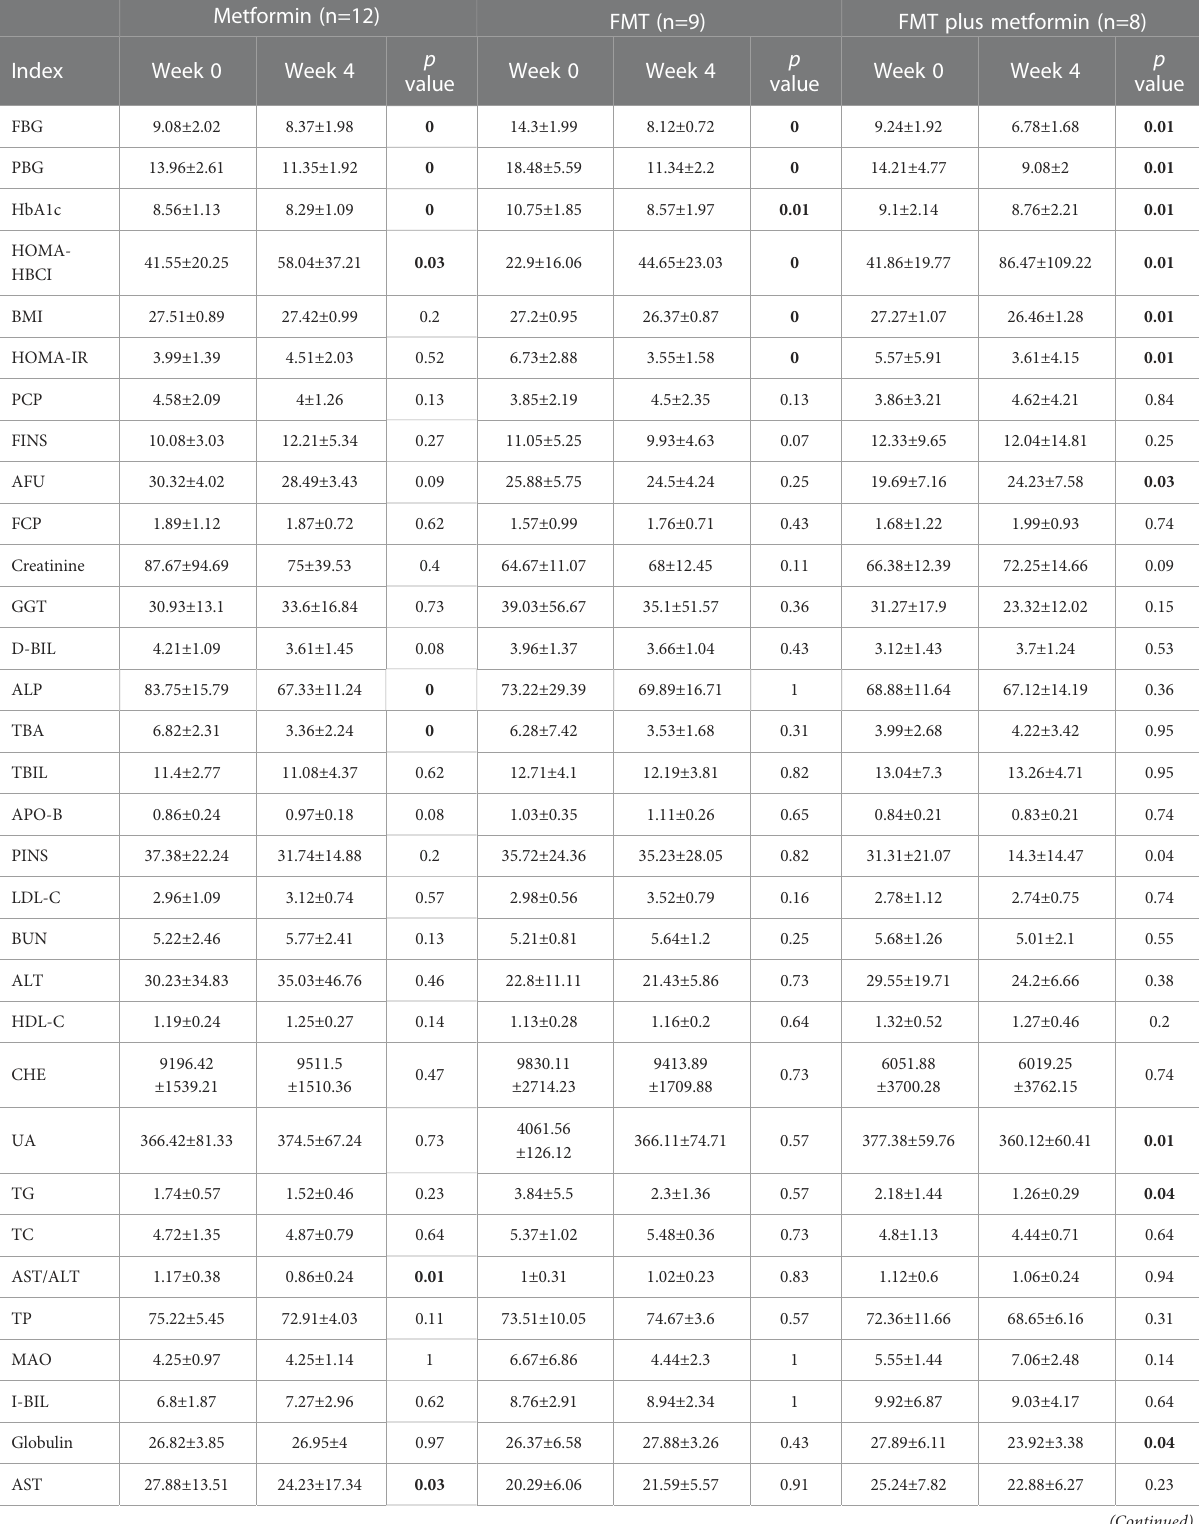
TABLE 1 Clinical data included in this